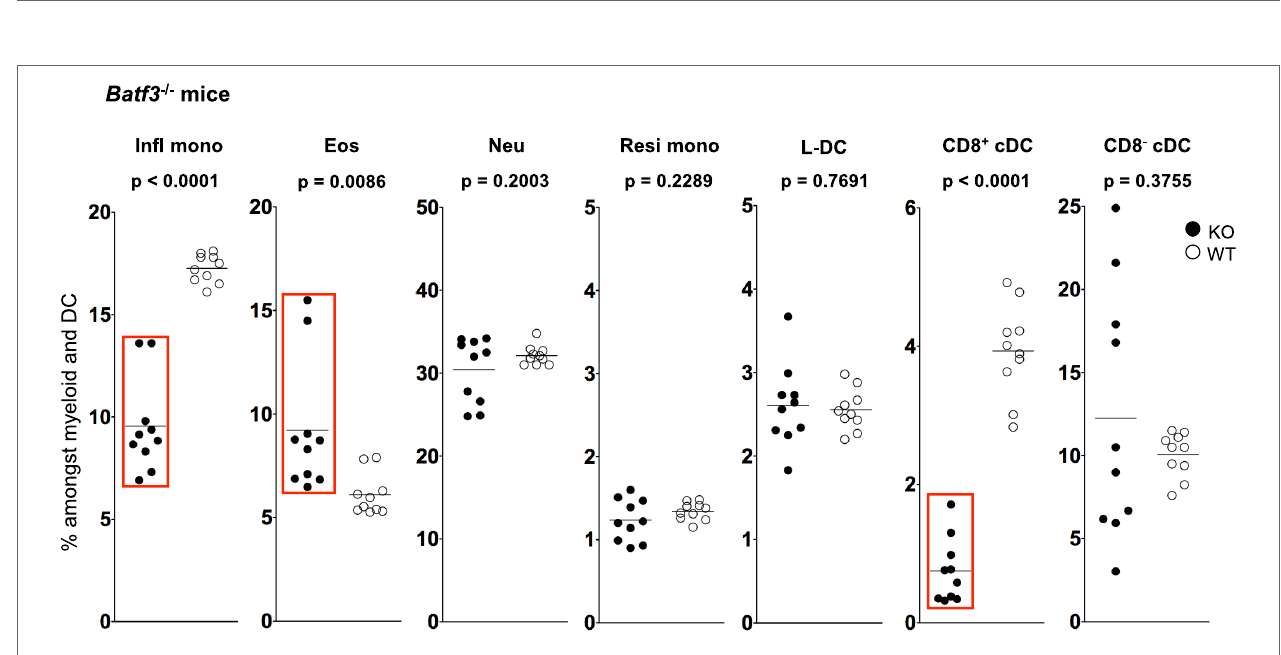
FigUre 4 | l-Dc development occurs independently of Batf-3 signaling . Splenocytes were harvested from B6.129S(C)- Batf3 tm1.1Kmm (Batf-3 − / − ) and C57BL/6J (wild-type) mice and prepared as described in Figure 1 . Cells were stained with two distinct antibody cocktails. The first included antibodies to CD11b, CD11c, Ly6C, Ly6G, MHC-II and CD8. The second contained antibodies to CD11b, CD11c, Ly6C, Ly6G, CD43 and Siglec-F. Prior to analysis, cells were stained with propidium iodide for gating live (PI − ) cells. CD11b hi CD11c − myeloid cells were gated to give Ly6C hi Ly6G − CD43 + Siglec-F − -inflammatory monocytes (Infl mono), Ly6C lo Ly6G − CD43 + Siglec-F + eosinophils (Eos) and Ly6C lo Ly6G + CD43 + Siglec-F − neutrophils (Neu). L-DC were gated as CD11b hi CD11c lo Ly6C − Ly6G − CD43 + Siglec-F − cells, while CD11b hi CD11c lo Ly6C lo Ly6G − CD43 hi Siglec-F − cells were gated as resident monocytes (Resi mono). CD8 + cDC were gated as CD11b − CD11c hi MHCII + CD8 + Ly6C − Ly6G − cells, while CD8 − cDC were gated as CD11b + CD11c hi MHCII + CD8 − Ly6C − Ly6G − cells. Subset size was estimated as % of the total DC and myeloid population in individual wild-type mice (WT) compared with Batf3 − / − mice (KO). A bar is used to show mean values and p values are given. Statistically different subsets ( p ≤ 0.05) are boxed.